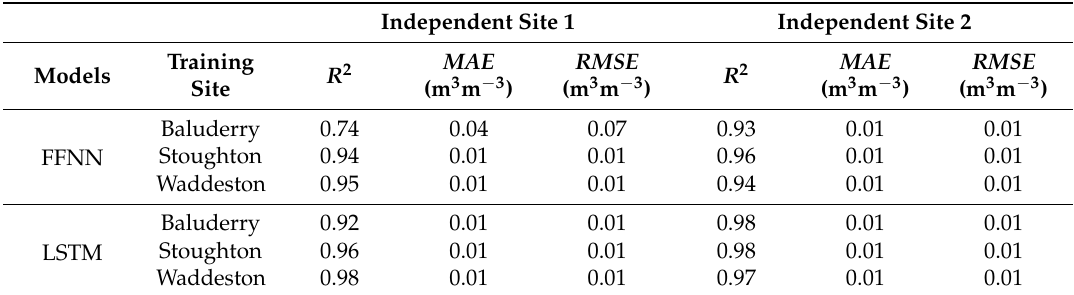
Table 7. Prediction performance of the neural network models for the independent